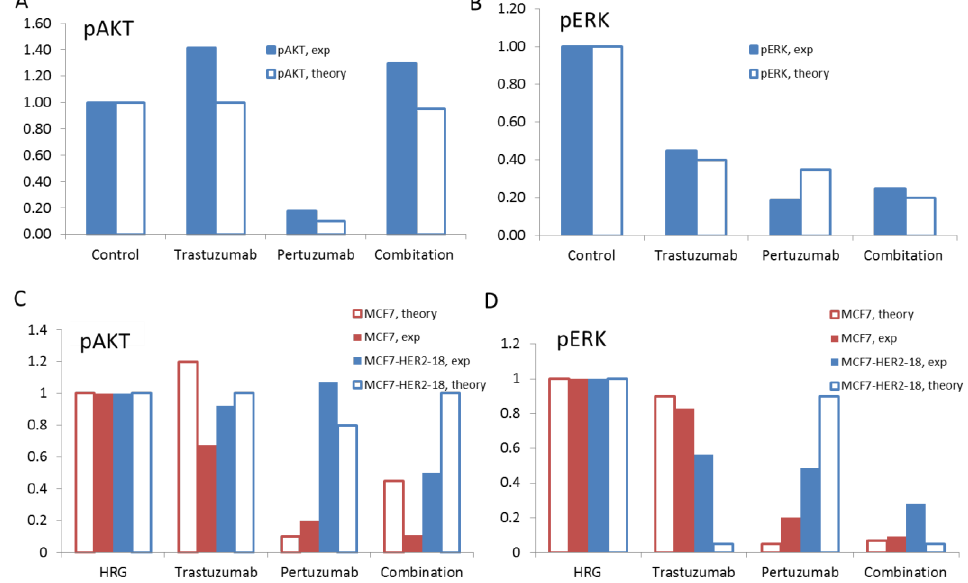
Figure 10. The theoretical results on the effects of trastuzumab, pertuzumab, and their combination on pAKT (A) and pERK ( B ) at the ratio HER3/HER2 = 0.5 and pAKT ( C ) and pERK ( D ) at the ratio HER3/HER2 = 0.1 (blue bars) and 1 (red bars). Comparison of the computational (open bars) and experimental (filled bars) data for pAKT ( A ) and pERK (B) in SKOV3 ovarian xenograft tumour after 14 days [28] and pAKT ( C ) and pERK ( D ) in MCF7 and MCF7-HER2-18 cells [57,58] treated by trastuzumab, pertuzumab, and their